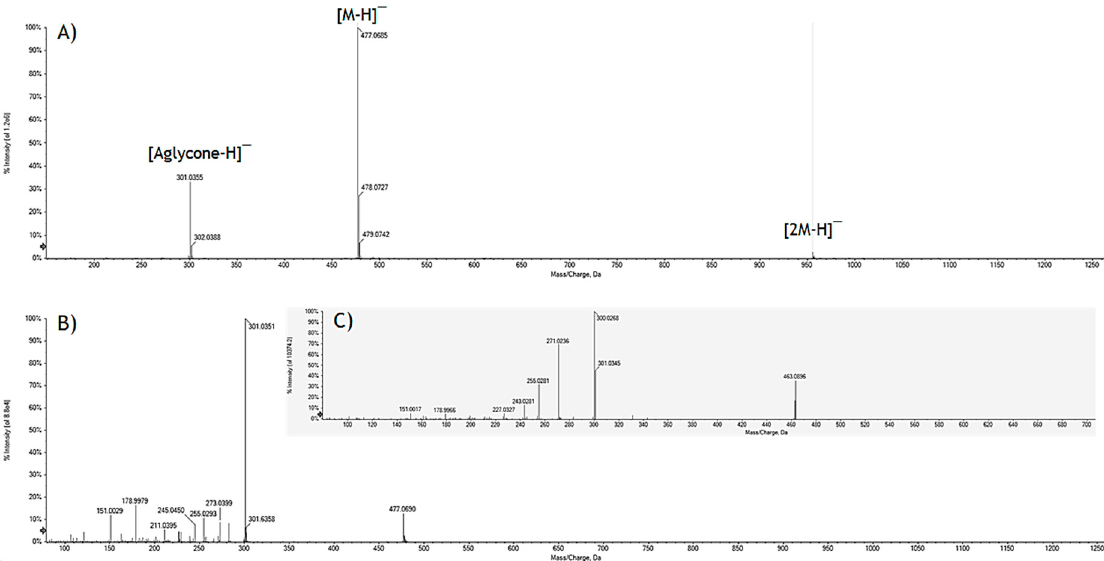
Figure 6. (A ) TOF-MS and ( B ) TOF-MS 2 spectra of the quercetin-3- O -glucuronide. ( C ) Quercetin-3- O - glucoside TOF-MS 2 spectrum.